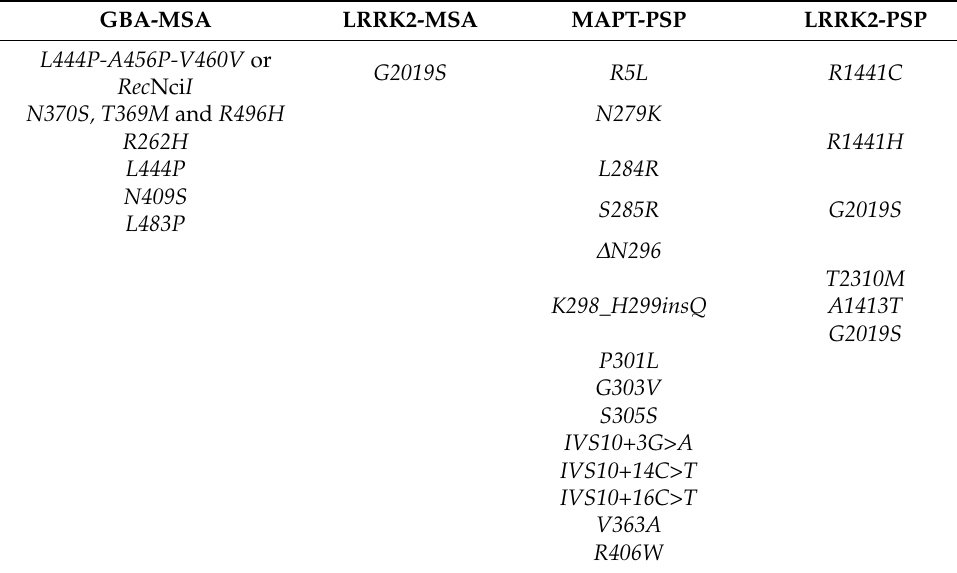
Table 1. Summary of MSA and PSP gene mutations .